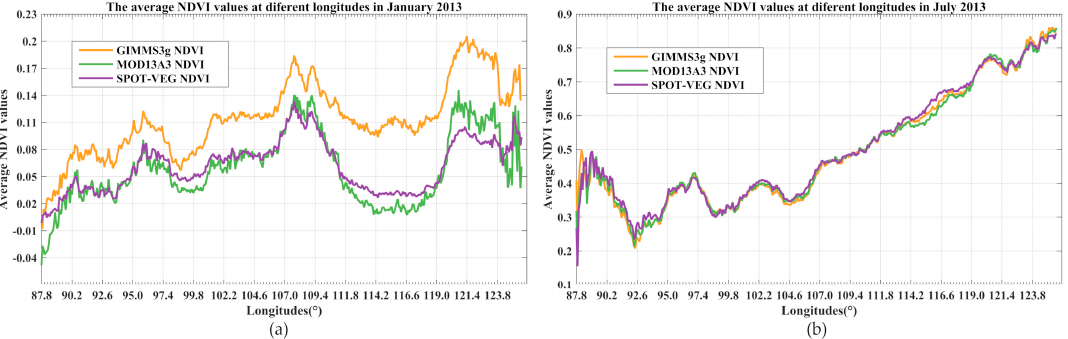
Figure 9. Average NDVI values at different longitudes from 87.8 ° E to 126.1 ° E in ( a ) January 2013 and ( b ) July 2013.